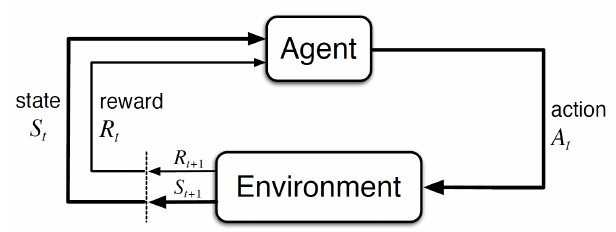
Figure 1. The agent-environment interaction in reinforcement learning